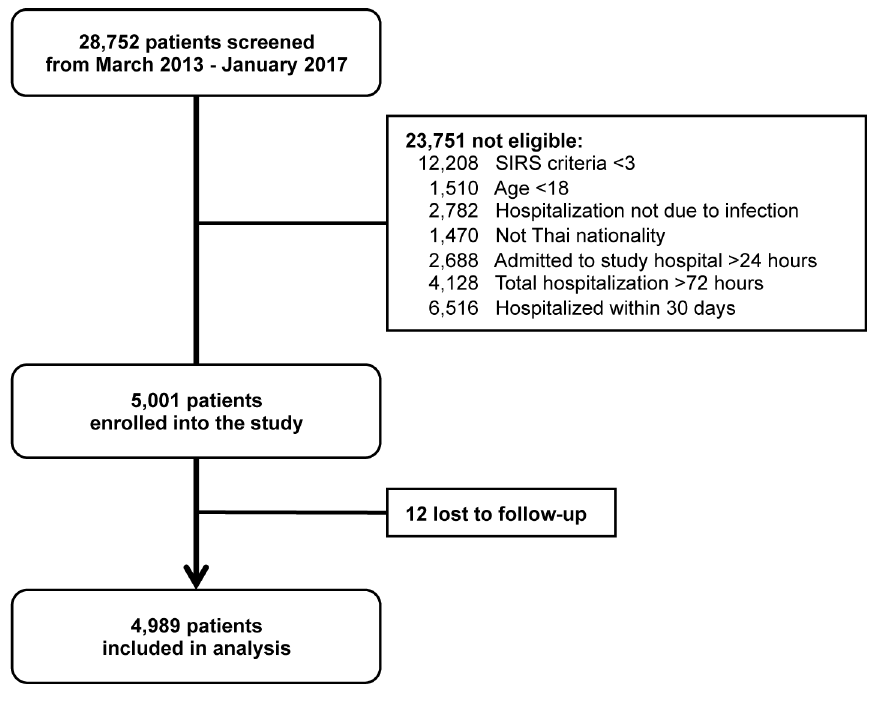
Fig 1. Study flow